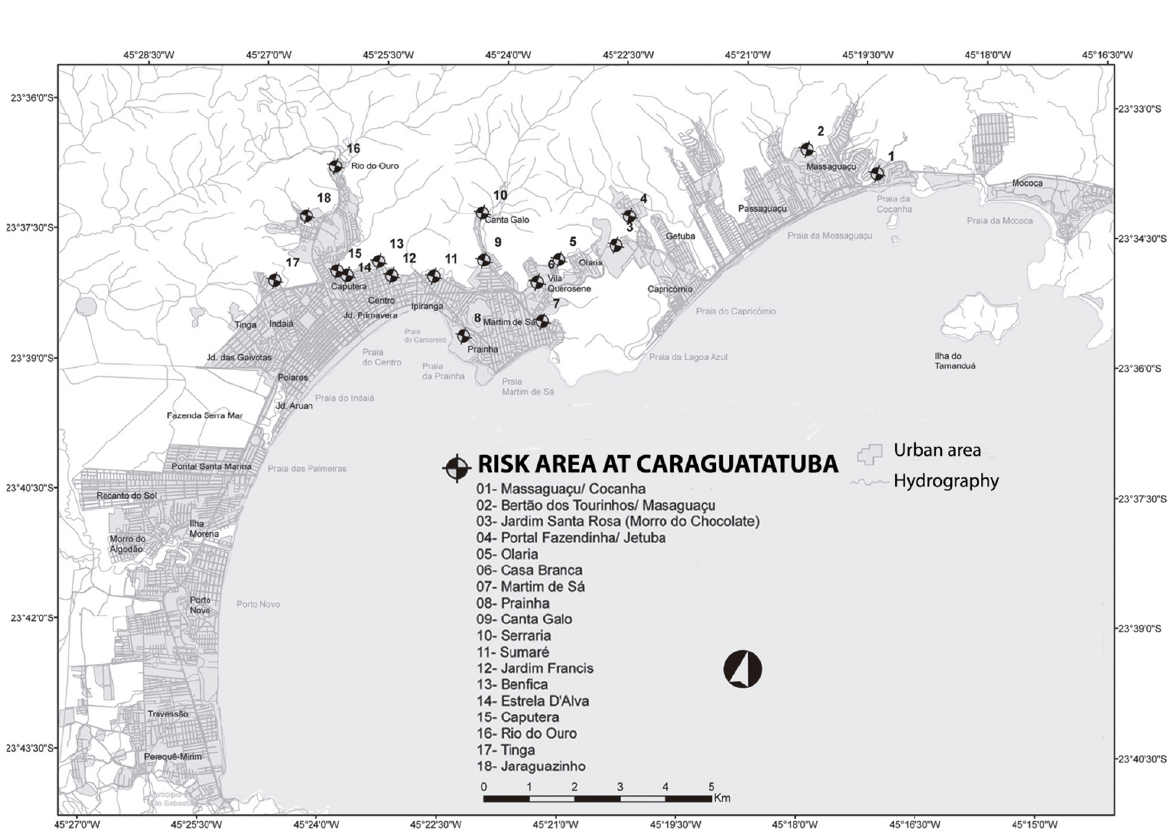
Figure 3. Environmental risk areas in Caraguatatuba (source: adapted from Marandola Júnior et al.